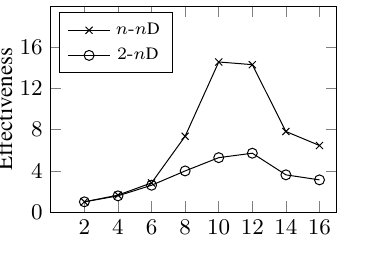
Figure 7. FPR for 2- n D query in IdealSim